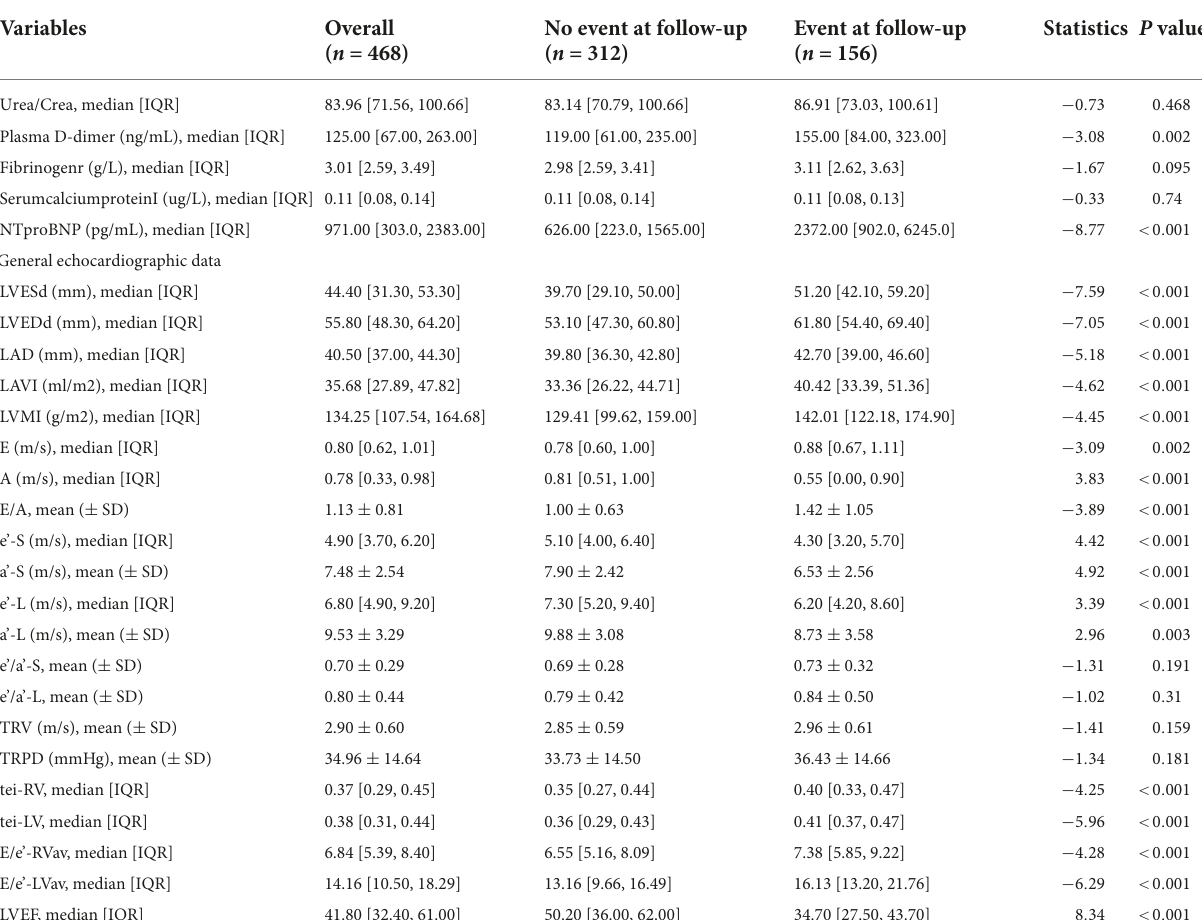
MACE, and solid horizontal line is patients without MACE. The graph shows the expected net benefit per patient in relation to the nomogram MACE risk prediction. Decision curve analysis indicated that the clinical validity of the model was moderate.